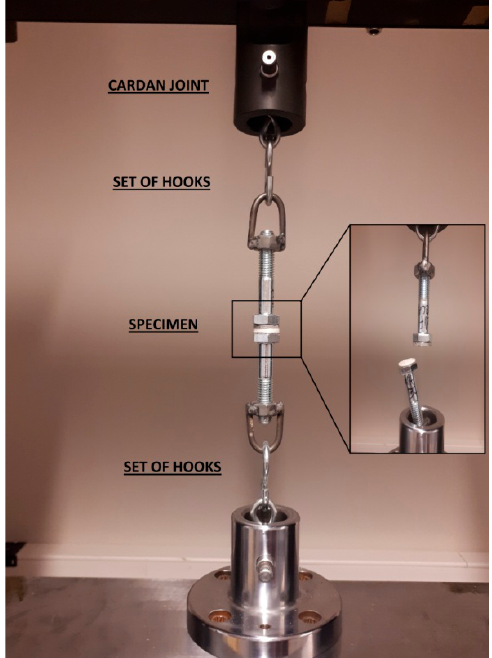
Figure 2. The specimen holder mounted in universal tensile machine.